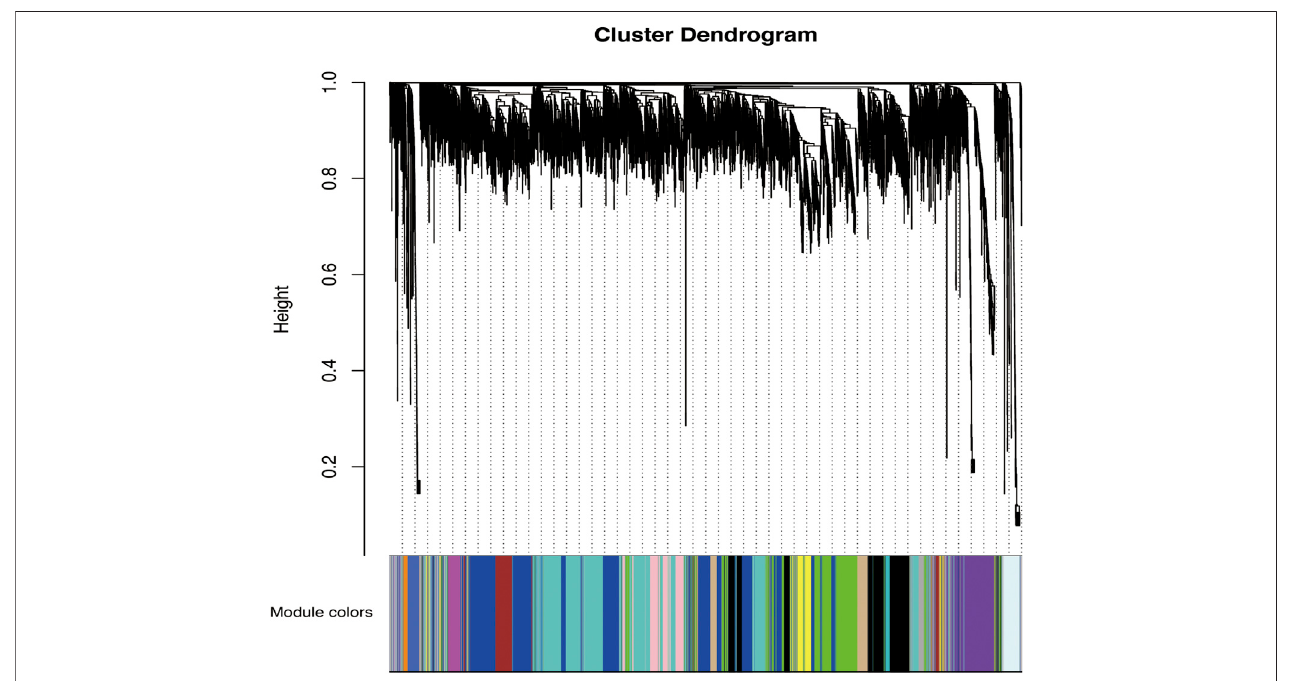
FIGURE 2 | Categorization of gene modules. The fi gure shows the clustering of genes, and the categorization of gene modules based on clustering. Branches of the same color were categorized into the same gene module. From our analysis, 27 co-expression modules were constructed and are shown in different colors here. These modules ranged from large to small based on the number of genes they included. The number of genes in each module is presented in Table 3 .